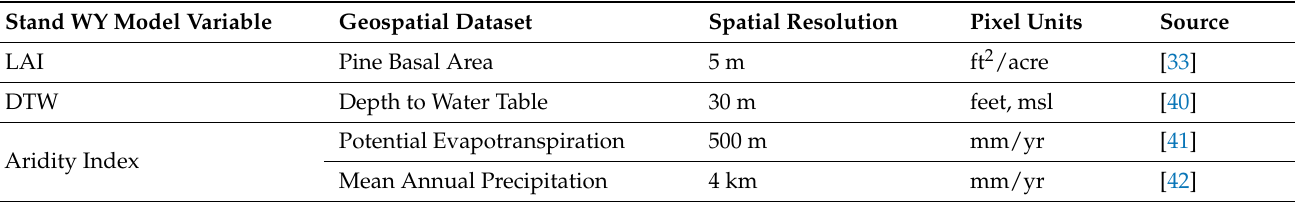
Table 1. Summary of geospatial datasets used in the spatial water yield (WY) workflow and their corresponding stand model variable. Spatial resolutions, pixel units, and data sources are also included.